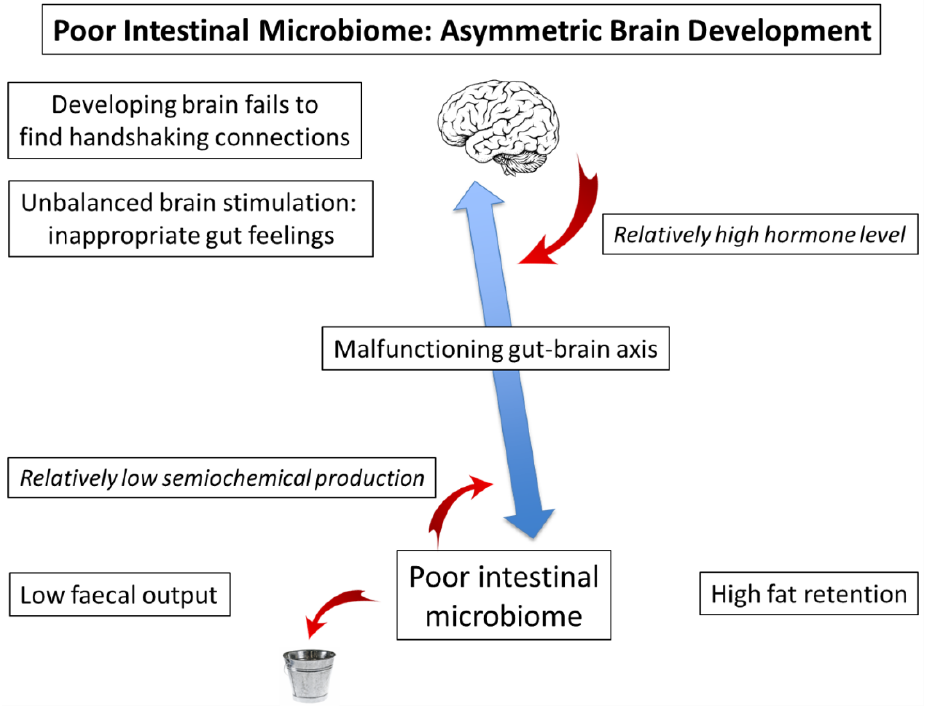
Figure 2. Inadequate formation of the gut – brain axis (a vicious circle, [13]). Left hand side: A failure to connect microbiome to gut leads to poor interoception in the brain, with unbalanced brain growth, poorly performing gut – brain axis, and low faecal energy output. Right hand side: Relatively high hormone levels reduce peristalsis, leaving the gut short of energy. Energy is retained within the body, increasing adiposity [52].